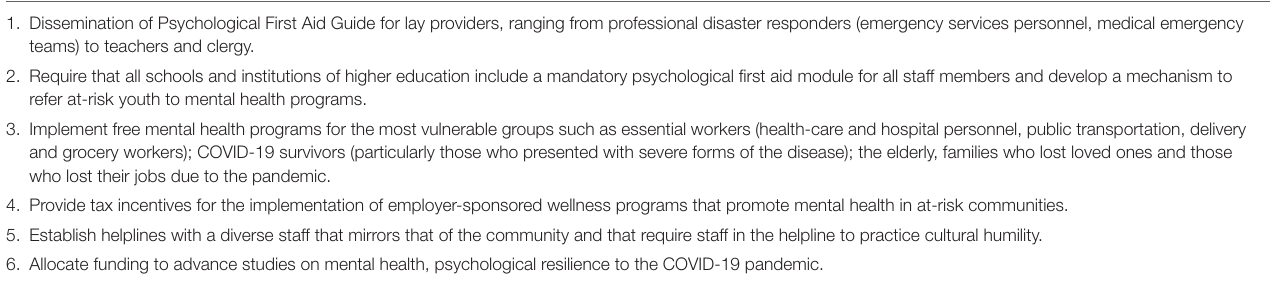
TABLE 1 | A roadmap toward the dissemination of culturally tailored psychological first aid frameworks during Covid-19